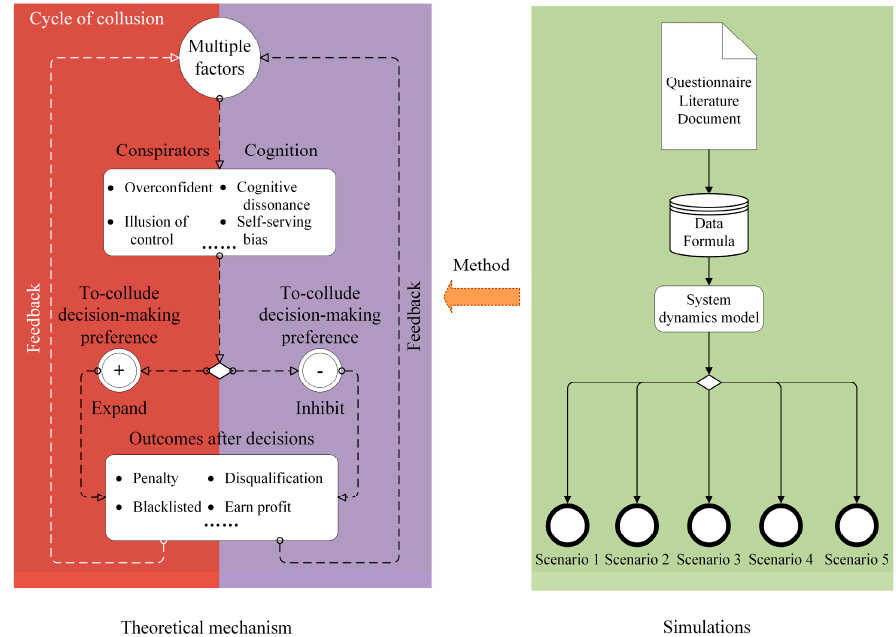
Figure 1. A conceptual framework and methodology